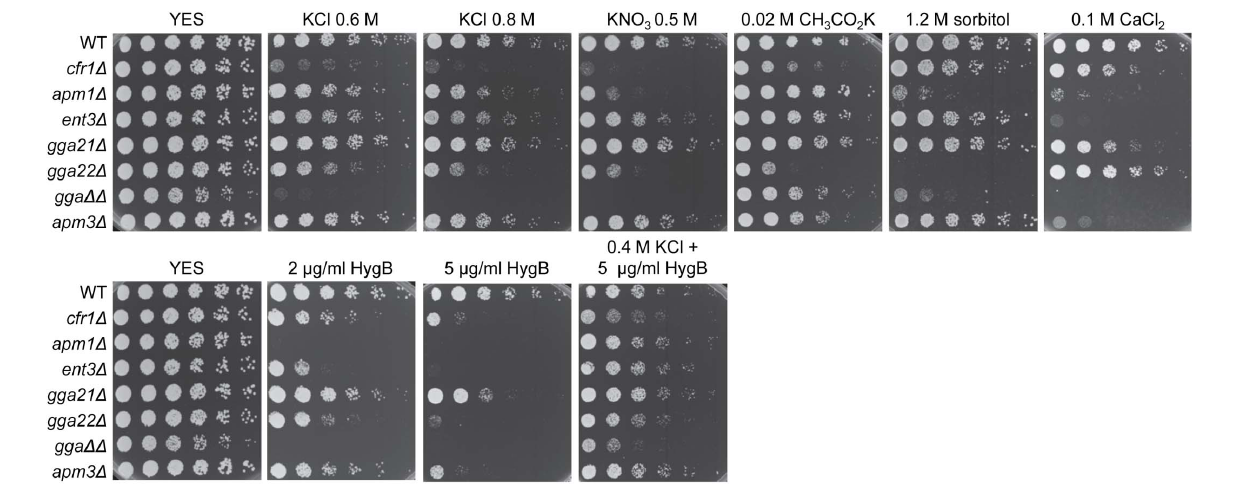
FIGURE 8 | Sensitivity of mutants defective in clathrin adaptors to stress. Cells from the indicated strains were spotted on YES (rich medium) and YES supplemented with the indicated compounds, and incubated at 28 ◦ C for 4 days. WT, wild-type; gga (cid:49)(cid:49) , gga21 (cid:49) gga22 (cid:49)